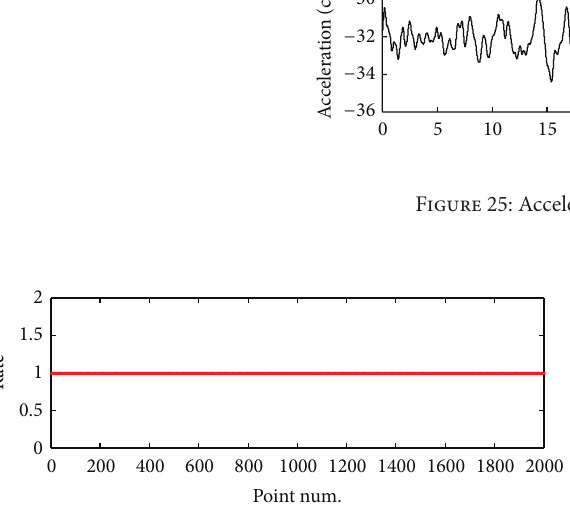
Figure 26: Continuous coincidence points.